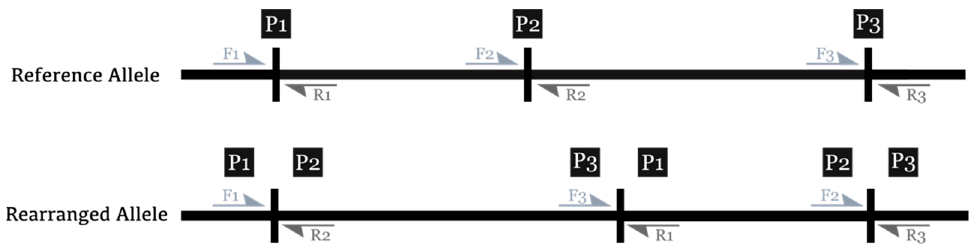
Figure A1. Primer design. Forwards and reverse primers were designed around the three breakpoints in both the reference and the rearranged alleles. Table A1. Sequence of forward and reverse primers used around the